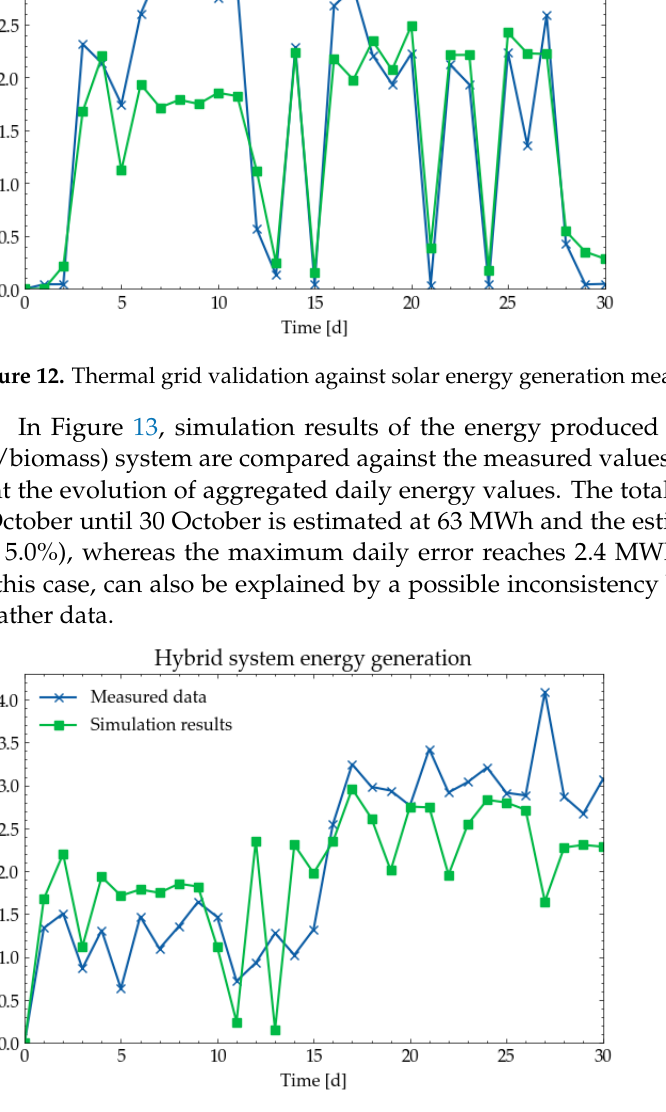
Figure 13. Thermal grid validation. Simulation results against total energy generation measure- ments.